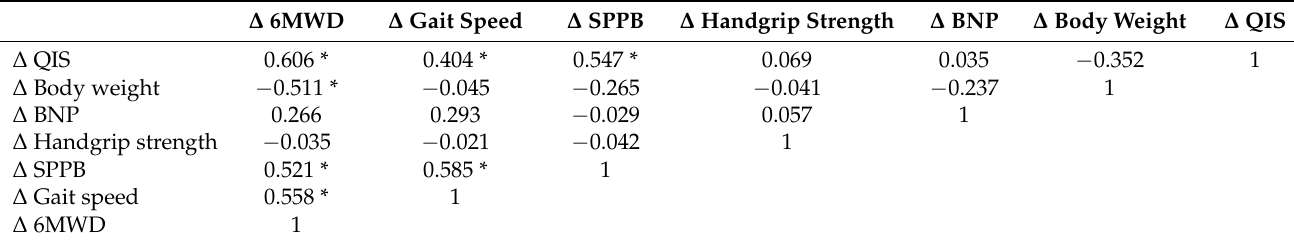
BNP, B-type natriuretic peptide; QIS, quadriceps isometric strength; SPPB, short physical perfor- mance battery; 6MWD, 6-min walking distance. * p < 0.05.